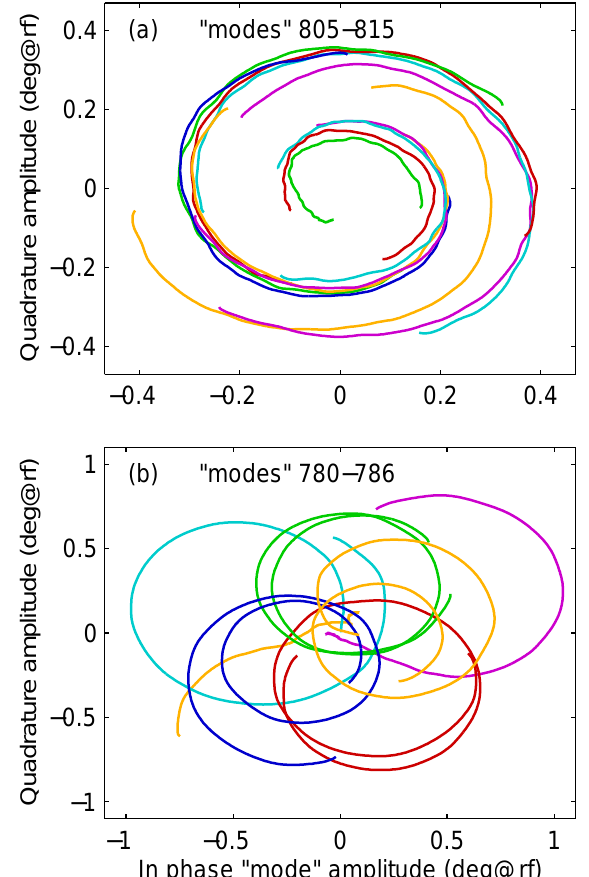
FIG. 8. (Color) (a) Average of modal phase space magnitudes A m ; m (cid:1) 775, 776, . . . , 815 (same data as Fig. 7). (b) Average coherent tunes, calculated using linear fits to F m ; m (cid:1) 775, 776, ... , 815 . Fitted tunes show negligible variation above m (cid:1) 798 , implying that the band of projections on the right- hand side of the dotted line contains only one eigenmode.